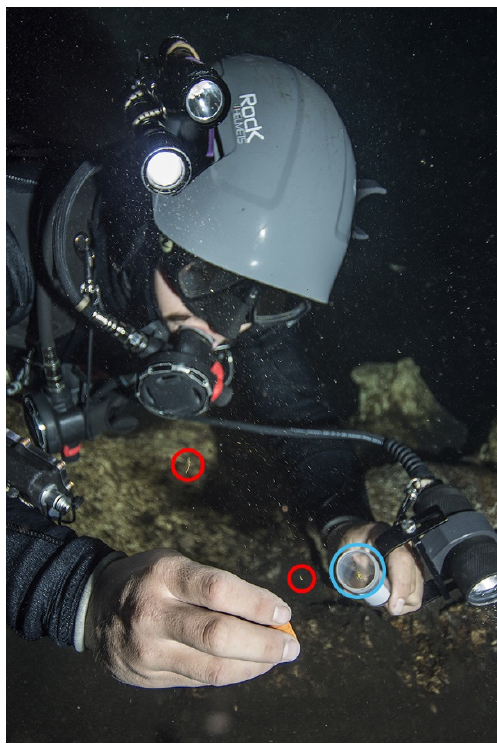
Figure 3 . Luis Arturo Liévano-Beltrán collecting A. cenotensis (red circles) and T. mitchelli (blue Figure 3. Luis Arturo Li é vano-Beltr á n collecting A. cenotensis (red circles) and T. mitchelli (blue circle) specimens from a cave in cenote Xelactún at 24 m depth on 25 February 2020. Courtesy of circle) specimens from a cave in cenote Xelact ú n at 24 m depth on 25 February 2020. Courtesy of Kayú Vilchis-Zapata. Kay ú